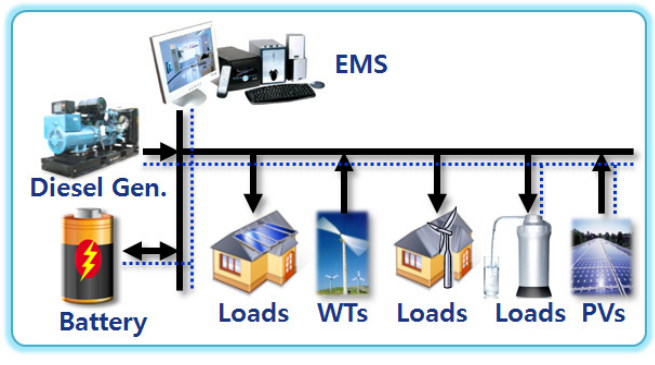
Figure 1. Example of a remote